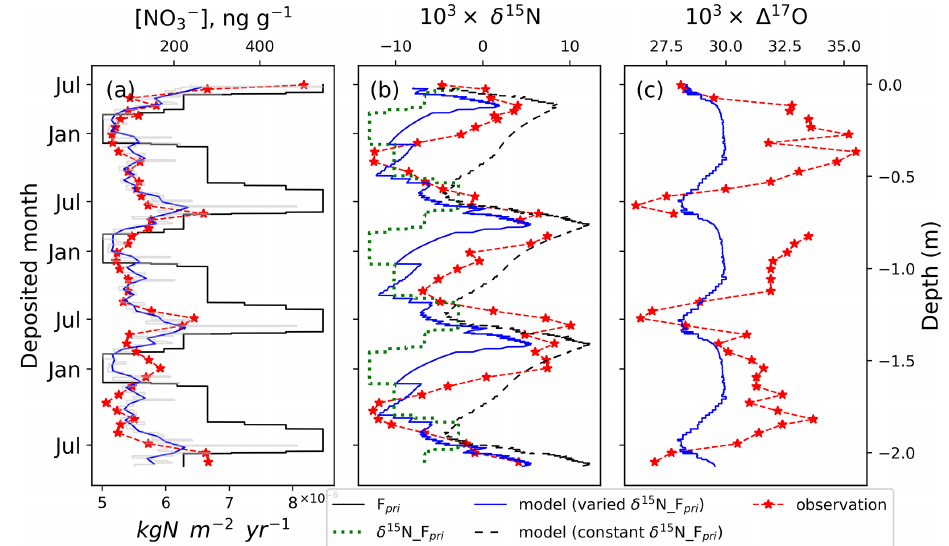
Figure 1. Snowpack nitrate concentration and isotope profiles at Summit, Greenland (red: observations; blue: modeled). The gray curve in (a) is the modeled weekly data, while the blue curve is the monthly average. The dashed green line in (b) represents measured δ 15 N in surface snow throughout a year (Jarvis et al., 2009). The measured minimum (cid:49) 17 O ( NO − photochemistry is the most